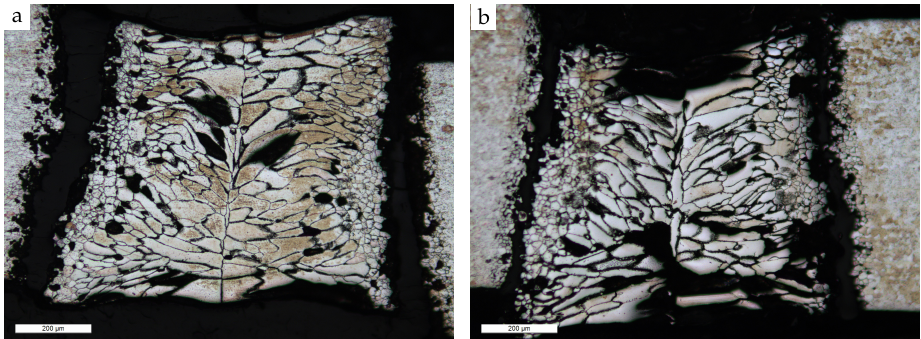
Figure 13. Etched cross-section of AISI430 after ( a ) 10h and ( b ) 20h of exposure to the corrosive environment. Weld produced at an energy input of 24 J · mm − 1